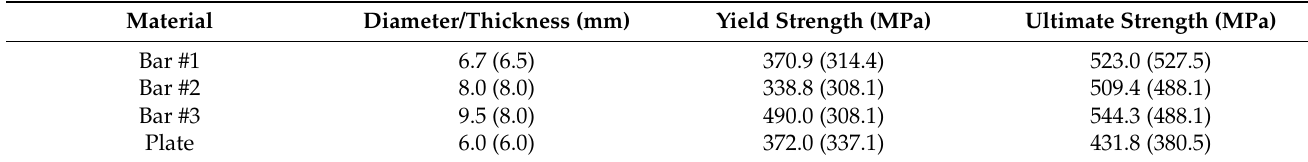
Table 2. Testing results of steel properties.